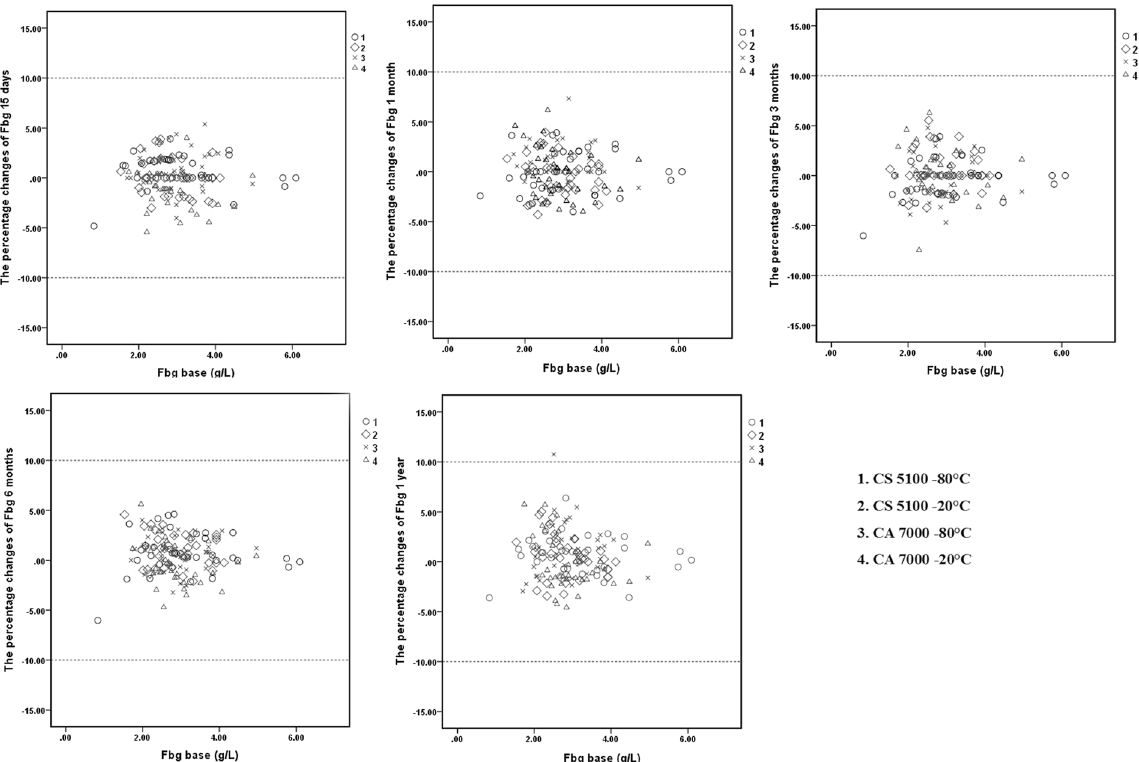
Figure 3. Percent changes of Fbg in samples stored for 15 days, 1 month, 3 months, 6 months, and 1 year and detected by the CS5100 and CA7000 systems. 1: Samples stored at − 80 °C and analysed by the CS5100 system; 2: samples stored at − 20 °C and analysed by the CS5100 system; 3: samples stored at − 80 °C and analysed by the CA7000 system; 4: samples stored at − 20 °C and analysed by the CA7000 system. The two dotted lines in the figures represent plus or minus 10%